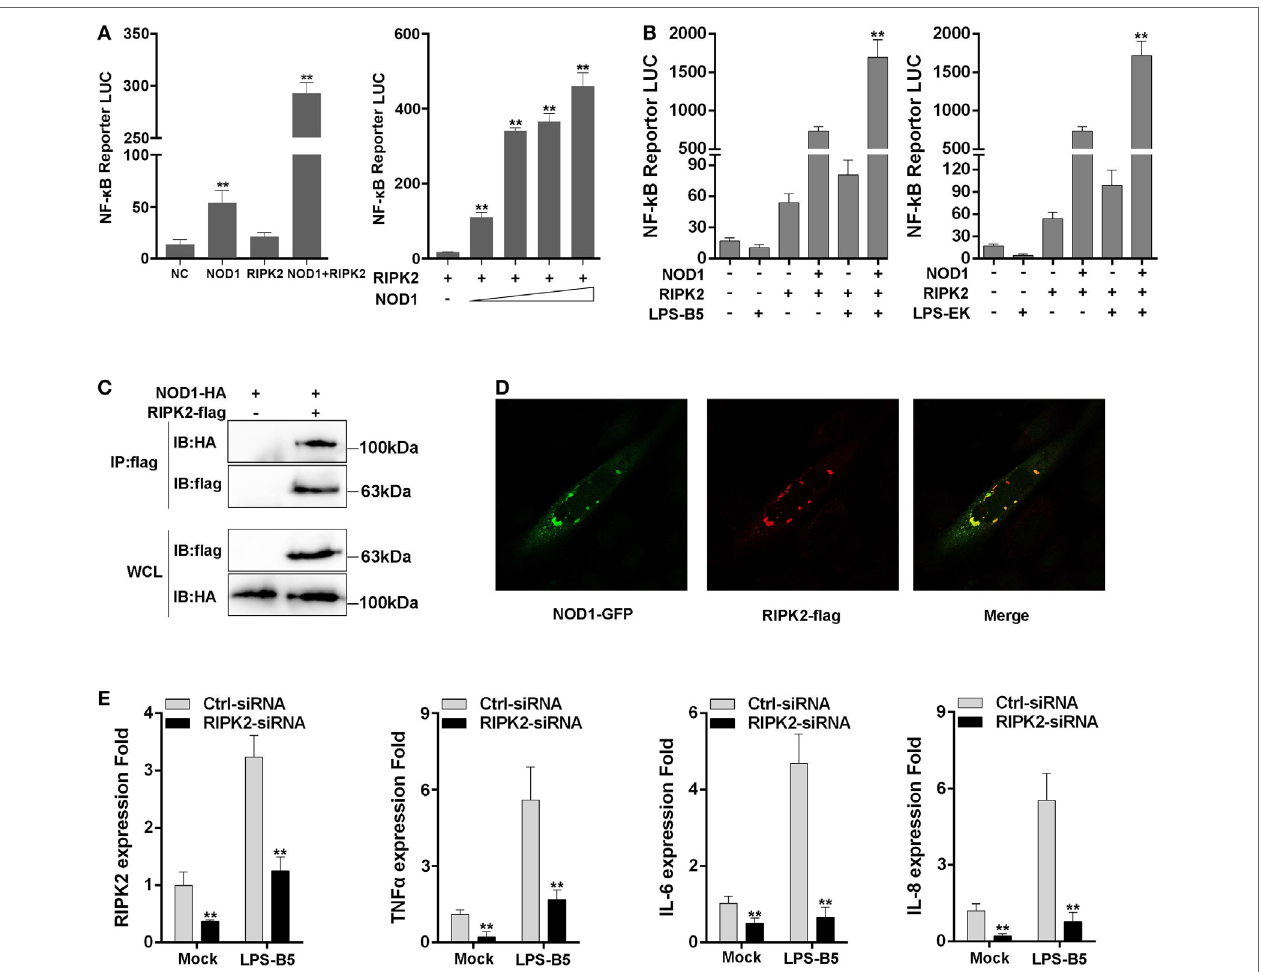
FigUre 8 | NOD1 recruits RIPK2 to activate the NF- κ B signaling pathway. (a) Co-transfection of miiuy croaker RIPK2 and miiuy croaker NOD1 expression plasmids into HEK293 cells, and after 48 h of transfection, the luciferase activity was detected. Next, co-transfection of RIPK2 and different amount of NOD1 expression plasmids into HEK293 cells to perform a concentration gradient experiment, pRL-TK plasmids was used as the internal control. (B) HEK293 cells, which have been transfected with NOD1 and RIPK2 plasmids, were stimulated with lipopolysaccharide (LPS)-B5 and LPS-EK, pRL-TK plasmids were used as the internal control, and after 12 h of stimulation, cells were collected and luciferase activity was detected. (c) Immunoprecipitation analysis of NOD1 and RIPK2. A cropped HA blot is shown for IP and input, a cropped Flag blot is shown for input. For un-cropped HA and Flag blot, see Figure S5 in Supplementary Material. (D) Immunostaining and confocal imaging experiment of NOD1 and RIPK2. (e) Transfection of RIPK2-siRNA into miiuy croaker macrophages, which were treated with LPS-B5, and the expression of RIPK2, TNF α , IL-6, and IL-8 were detected. The data were represented as mean ± SE, and the statistically significant differences were expressed with asterisks (* P < 0.05 and ** P <